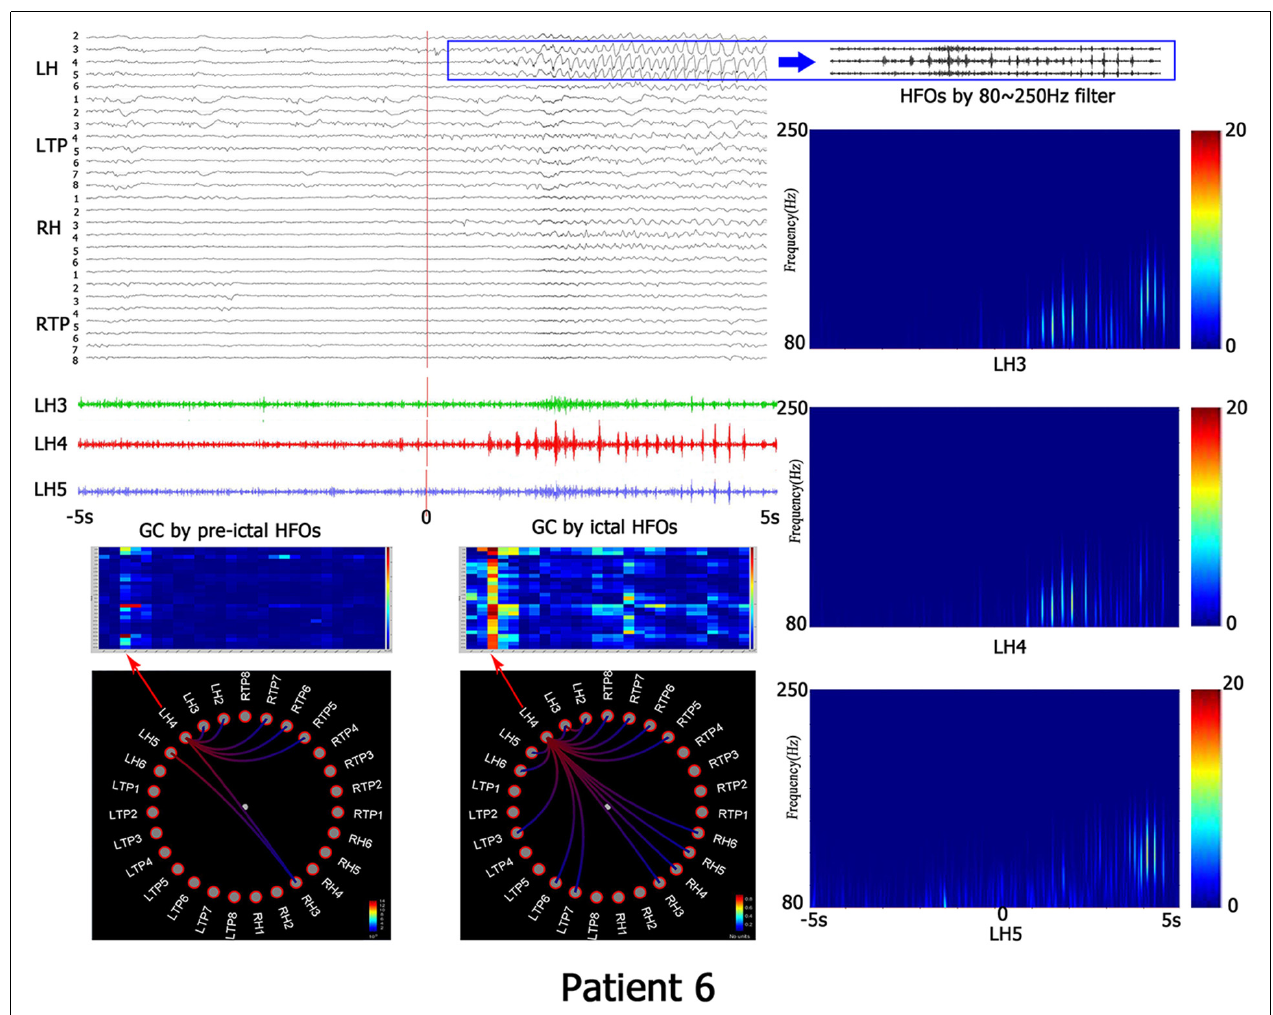
FIGURE 1 | This is the representing result of patient No. 6. All recorded channels are in top left corner, the time scope is 10 s, the red line represents the beginning of ictal HFOs, blue PANE shows the HFOs by 80–250 Hz filter. The left down corner is the matrix and granger causality (GC) figures which indicates the causality information. The right line is the time-frequency analyzed by wavelet transform (WT). LH, left hippocampus; LTP, left temporal polar; RH, right hippocampus; RTP, right temporal